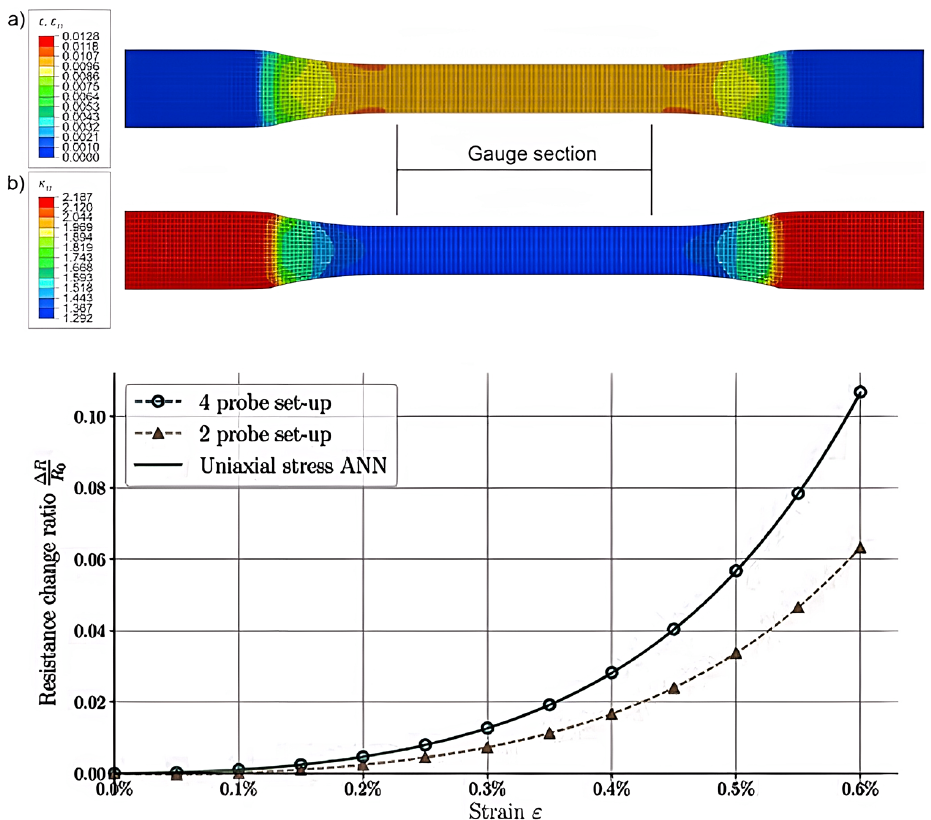
Figure 15. Application of ANN to epoxy/CNT nanocomposites for the manufacture of damage detecting sensors. Top: Contours of the ( a ) axial strain and ( b ) axial conductivity fields when a strain of 1% acts in the gauge portion. Down: measured changes in resistance for the 2-probe and 4-probe setups, compared with the expected resistance versus strain history predicted in the case of uniaxial stress (by the ANN). Reprinted from Ref. [112], copyright 2019, with permission from Elsevier.